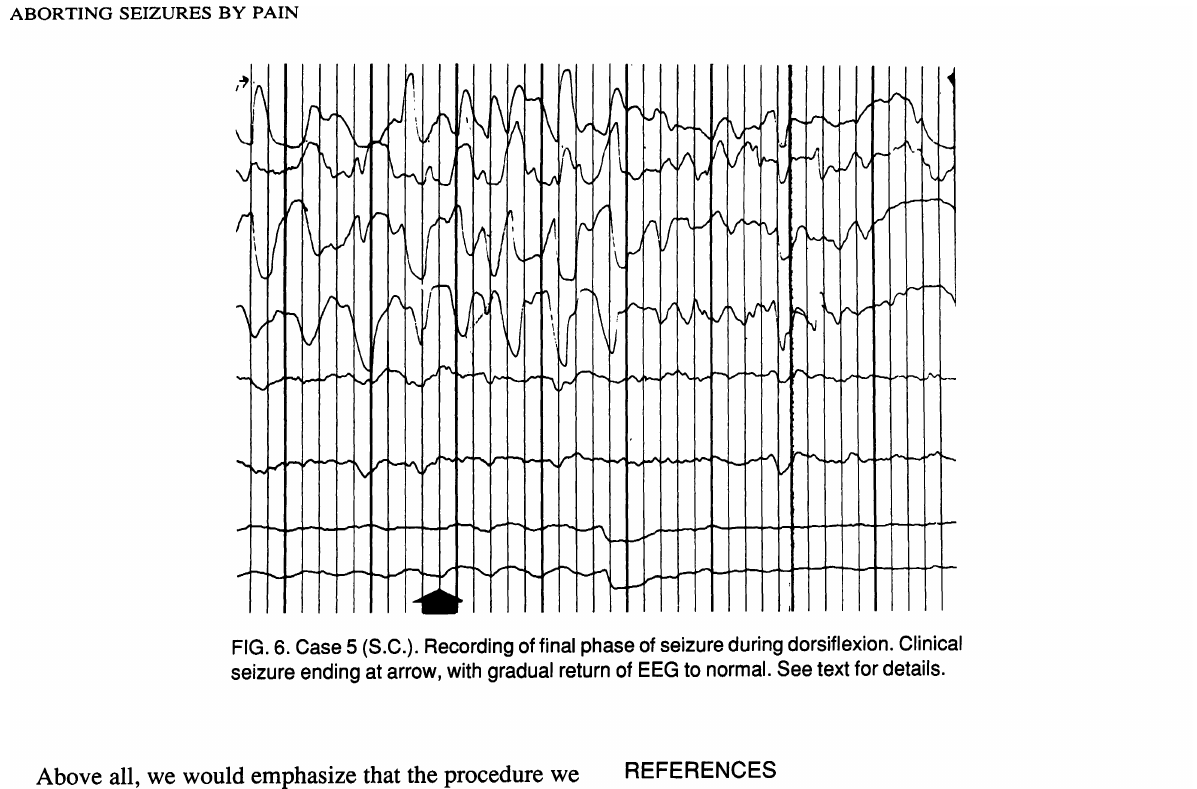
FIG. 6. Case 5 (S.C.). Recording of final phase of seizure during dorsiflexion. Clinical seizure ending at arrow, with gradual return of EEG to normal. See text for